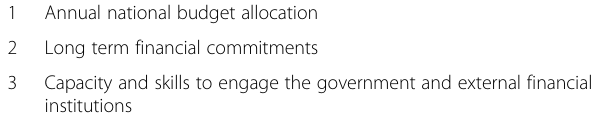
Table 7 The foundation of predictable and sustainable financial resources